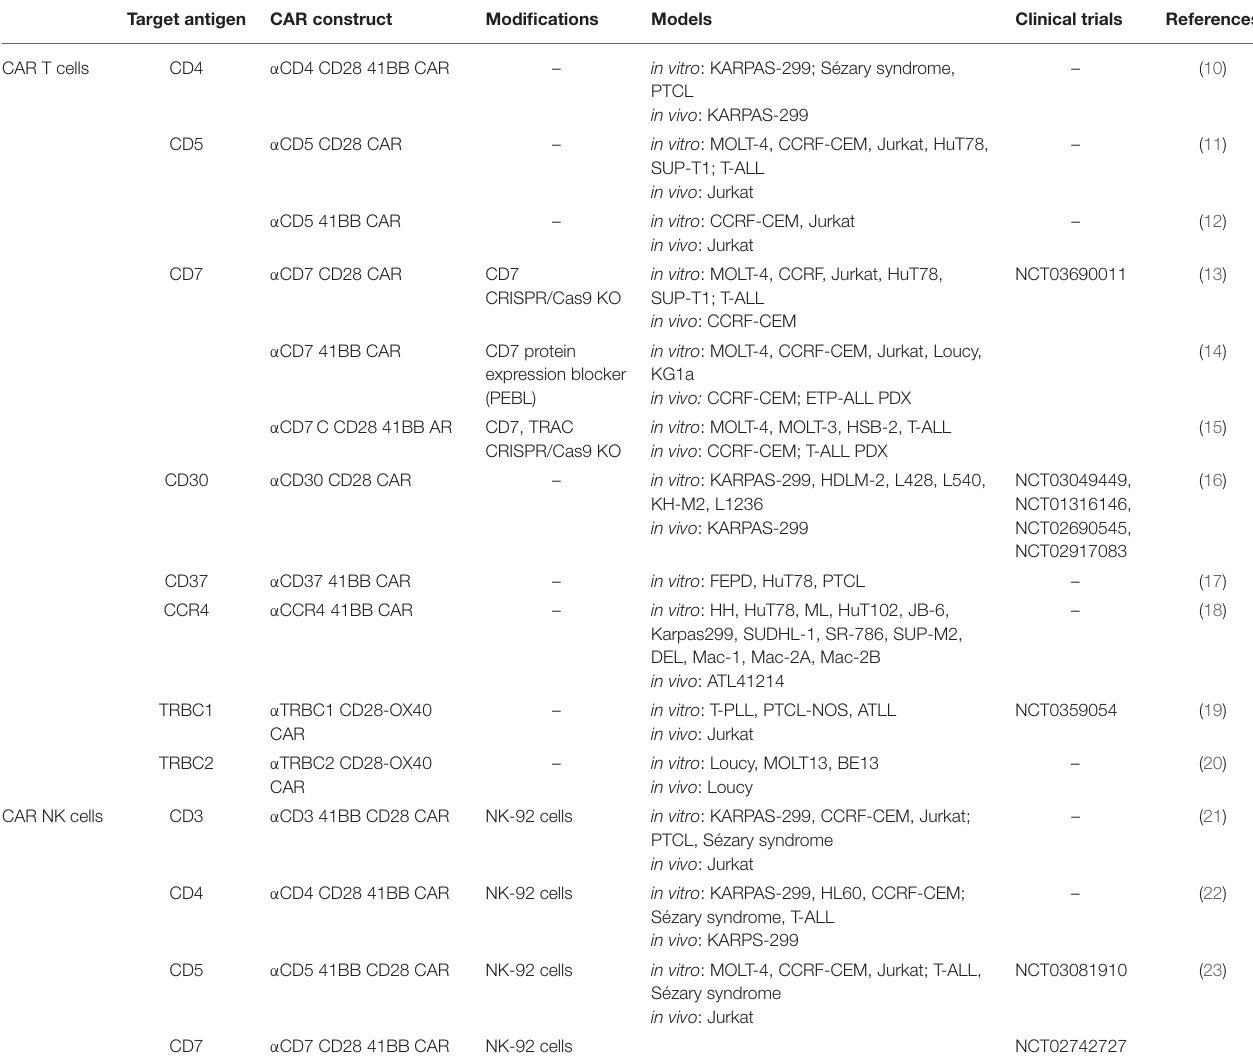
TABLE 1 | CAR T/NK cells for the treatment of